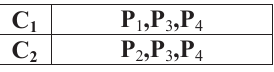
Fig 5. user page priority matrix